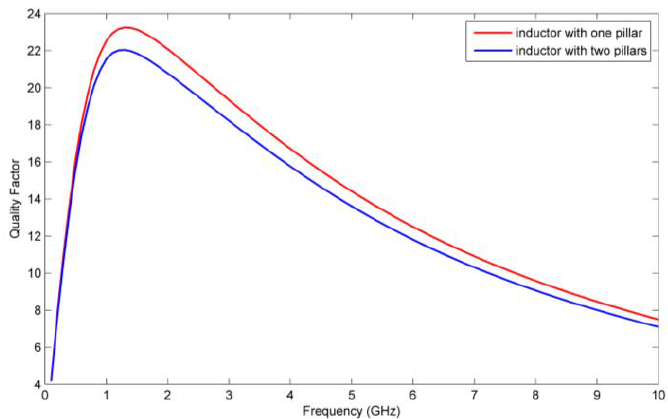
Figure 17. Quality factors of the inductors with single and double auxiliary pillar(s).